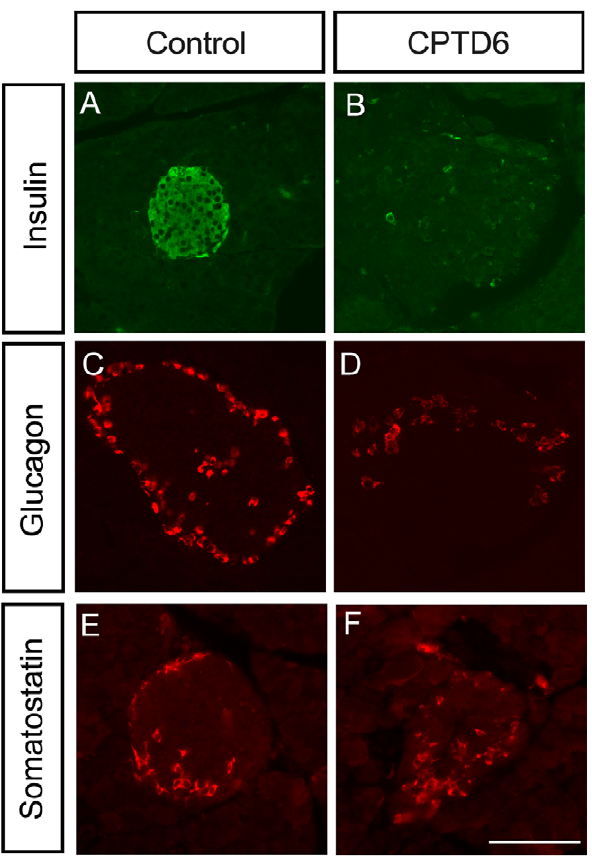
Figure 3. Expression analysis of pancreatic endocrine hor- mones. Images show immuno-stainings for insulin ( A , B ), glucagon ( C , D ), and somatostatin ( E, F ) in sections through the pancreas of control ( A , C , E ) and CPTD6 ( B , D , F ) mice sacrificed 5 weeks post-injections. Insulin expression is almost completely abolished in CPTD6 islets compared with control islets ( A, B ) . The number of cells staining positive for glucagon is also decreased in the CPTD6 islets compared to controls ( C, D ). Somatostatin expression is more moderately reduced in the CPTD6 islets with most CPTD6 islets showing fewer positive cells compared to the controls. ( E, F ). Images are representative of at least four animals from each group. Scale bar, 50 m m.